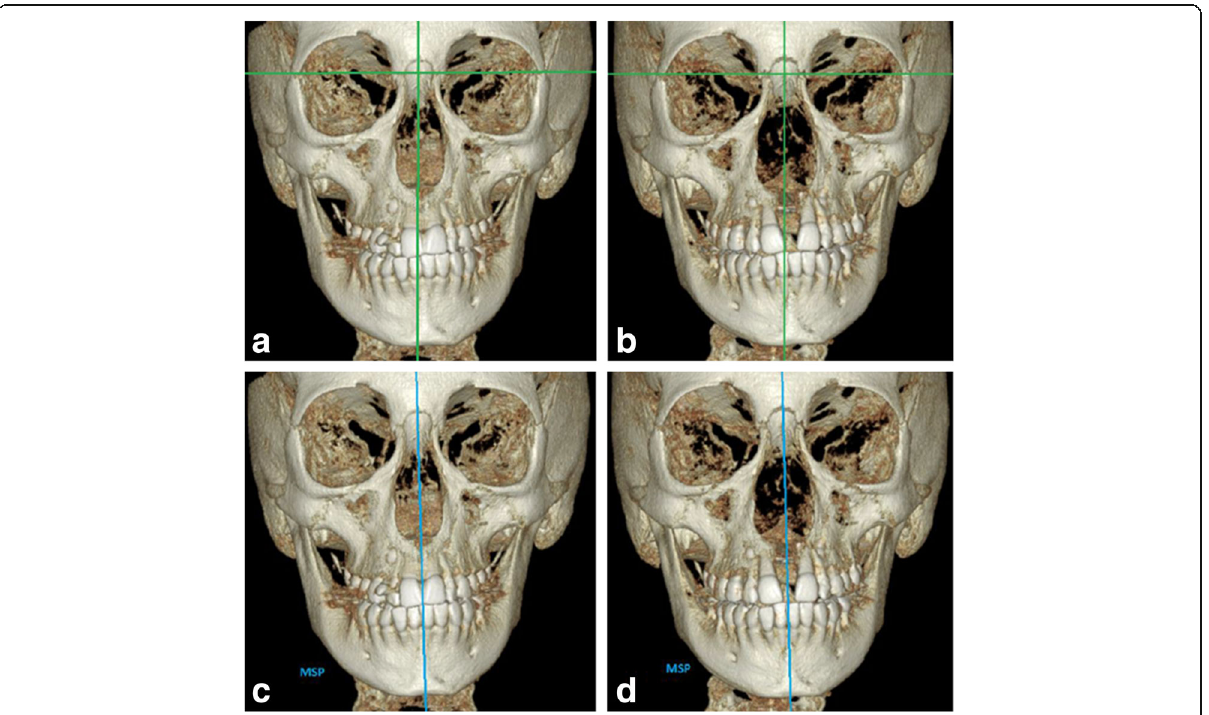
Fig. 9 Reference lines used in conventional 2D postero-anterior cephalometric analysis: a pre-expansion and b post-expansion; ANS is located on the left side of the vertical reference line. Maxillary sagittal plane (MSP) as novel reference plane: c pre-expansion and d post-expansion; ANS is located in the MSP